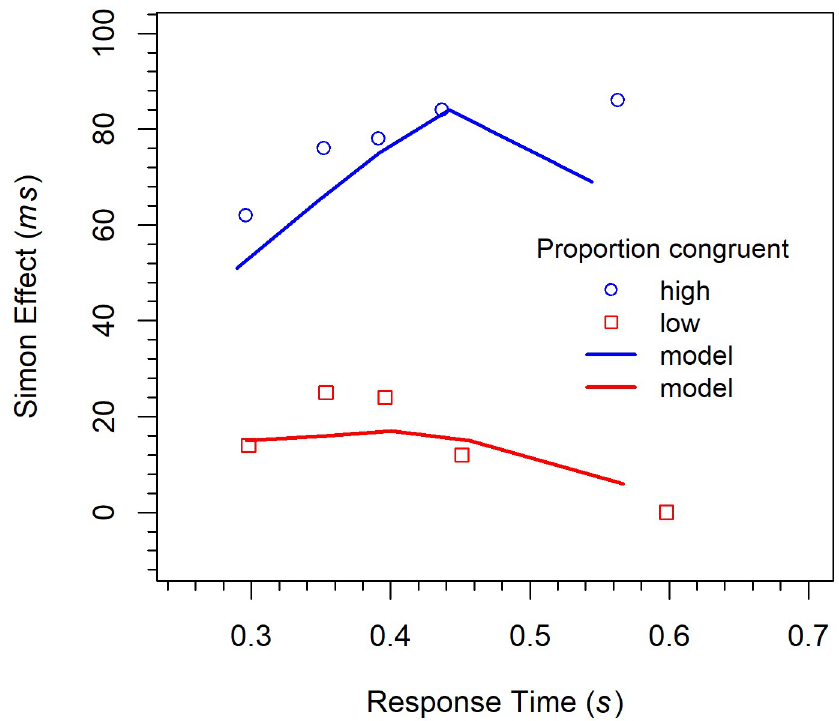
Fig 11. Delta functions for the different conditions in Experiment 3 (Simon task). The lines represent the fit of the DMC model.